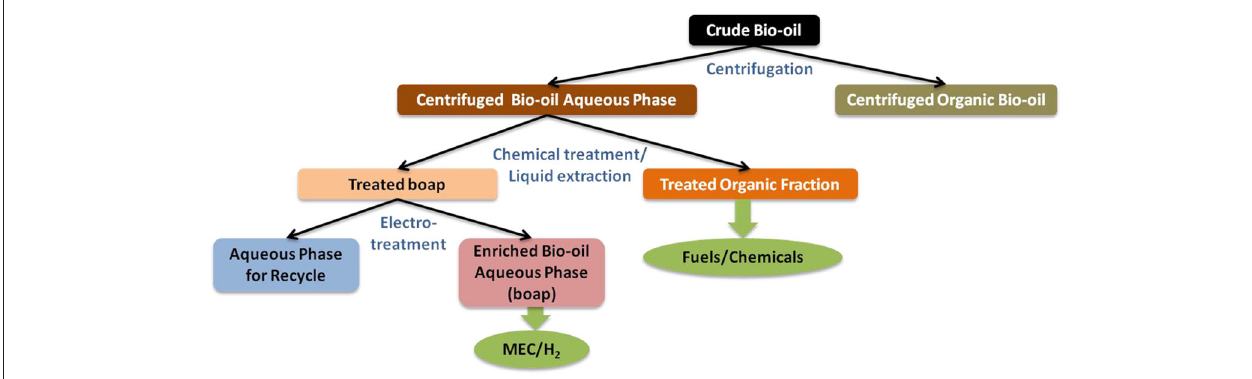
FIGURE 1 | Separation scheme integrating physical, chemical, and electro-separations to fractionate bio-oil for production of hydrogen, fuels and chemicals. Figure reprinted with permission from (Borole, 2015).